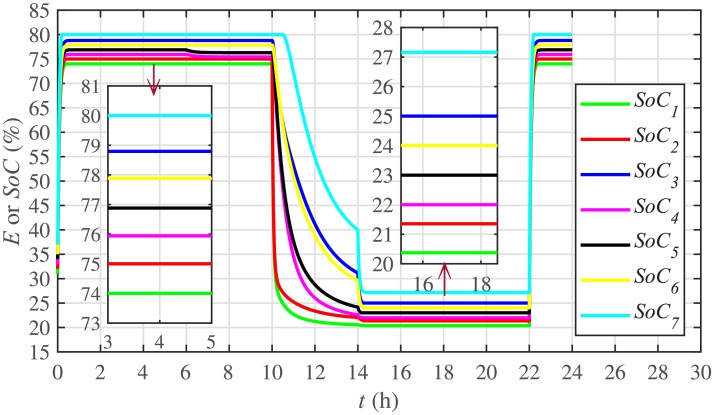
SoC tracking under case 5. [27].